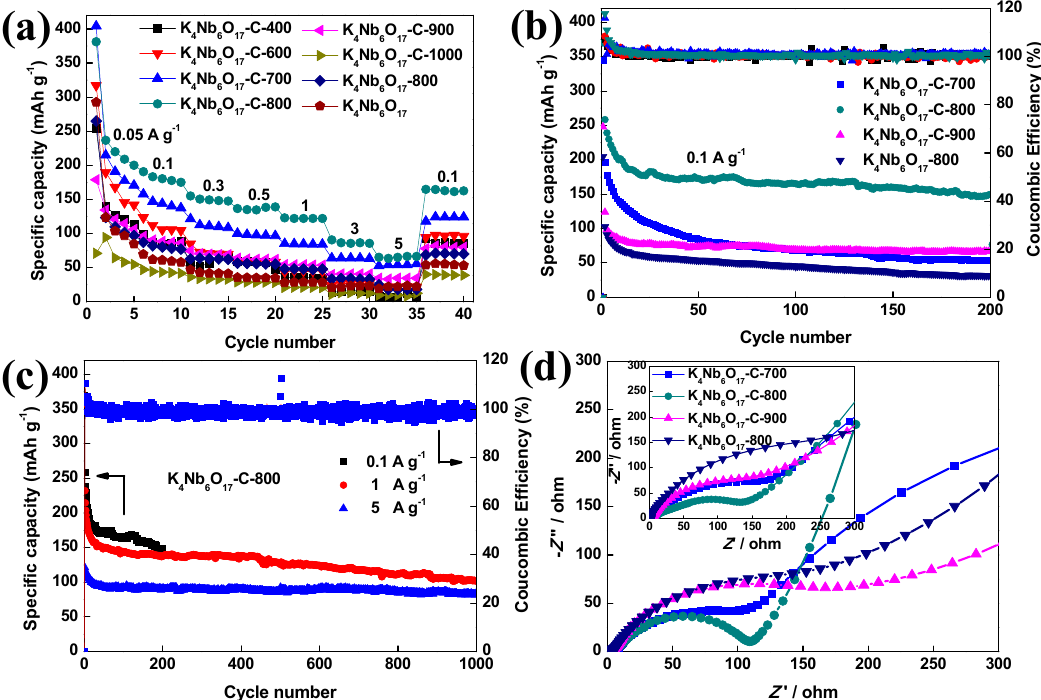
Figure 7. ( a ) Comparison of the capacities in dependence of cycle number of K 4 Nb 6 O 17 -C-800 half-cells at various current densities from 0.05 to 5 A g − 1 . ( b ) The cycling stability of samples at a current density of 0.1 A g − 1 . ( c ) The cycling stability of K 4 Nb 6 O 17 -C-800 at a current density of 0.1, 1, and 5 A g − 1 . ( d ) Nyquist plots of half-cell of the synthesis of K 4 Nb 6 O 17 -C nanosheet. The inset shows that the Nyquist plots of K 4 Nb 6 O 17 -C sample after 200 cycles with a current density of 0.1 A g − 1 .